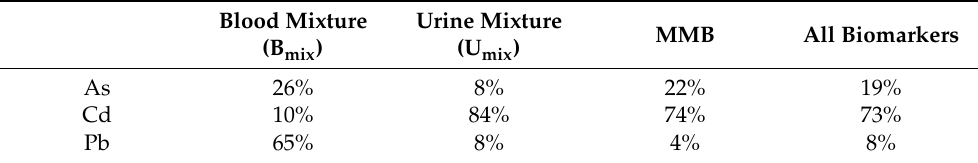
Figure 3. Percent change in eGFR for a 1-quartile increase in metal mixture levels. Plotted points are beta coefficients and lines are 95% confidence intervals. All models were adjusted for child age (years), child sex, indoor tobacco smoke exposure (referent group: no), SES (referent group: lower), and BMI (referent group: BMI z-score < 1). The p-values for these associations are: 0.04 (all biomarkers), 0.03 (MMB), 0.04 (urine mixture), and 0.37 (blood mixture). Table 3. Weights highlighting the contribution of each metal to the mixture effect of metals on eGFR. Larger weights indicated higher contributions to the mixture effect.